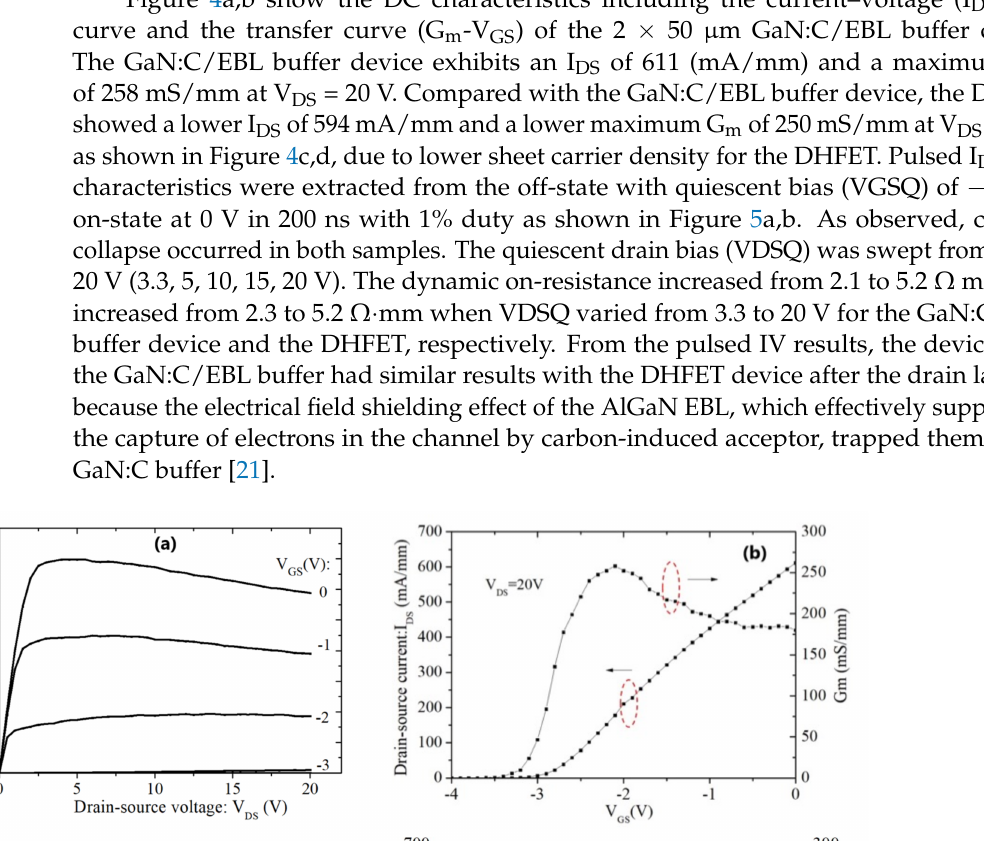
Figure 3. Vertical buffer leakage currents under forward and reverse bias (@Temperature: 25 ◦ C and 150 ◦ C) for ( a ) the GaN:C/EBL buffer device, and ( b ) the DHFET. Figure 4a,b show the DC characteristics including the current–voltage (I DS -V GS )